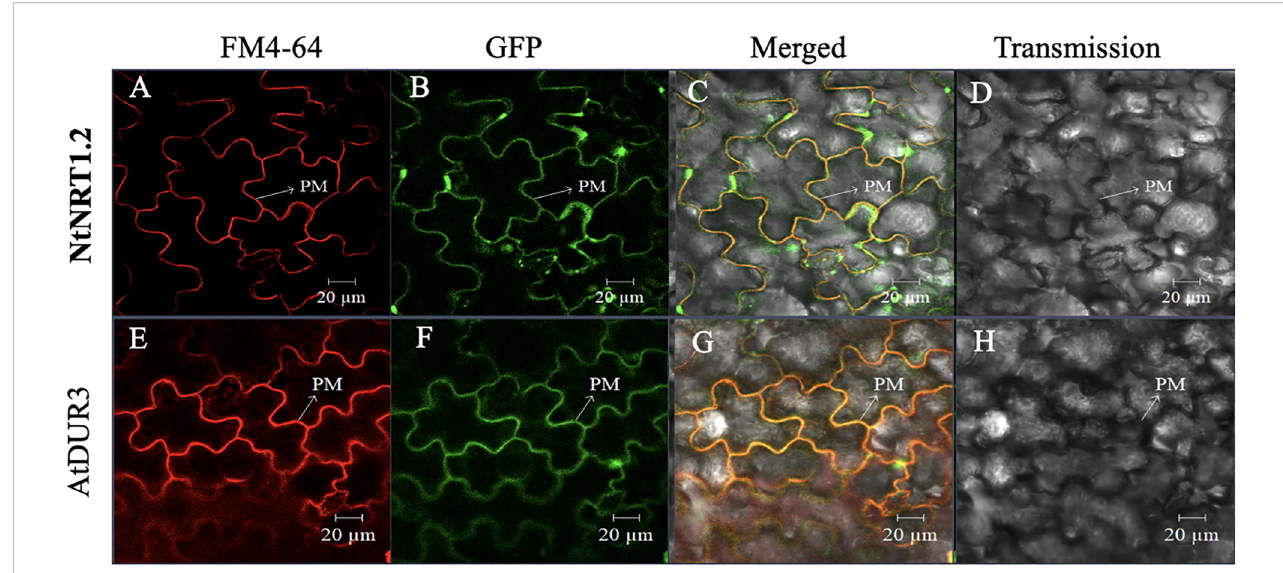
FIGURE 2 Subcellular localization of green fl uorescent protein (GFP)-tagged NtNRT1.1B in tobacco leaf epidermal cells. Agrobacterium GV3101 harboring the NtNRT1.1B::GFP construct was in fi ltrated into the epidermal cells of tobacco leaves for a transient expression of NtNRT1.1B , which was fused to the GFP gene (see Materials and methods). Representative images of the leaf epidermal cells were visualized using laser scanning confocal microscopy (see Materials and methods). The plasma membrane (PM) was dyed red with a chemical marker, FM 4-64, for 10 min (Bolte et al., 2004). The red (A, E) , green (B, F) , and yellow (C, G) are derived from the PM-staining marker FM 4-64, GFP, and superposition of red and green, respectively. (D, H) , images of leaf epidermal cells visualized in a transmission pattern. AtDUR3 (an Arabidopsis PM-localized high-af fi nity urea transporter; Liu et al., 2003) was used as